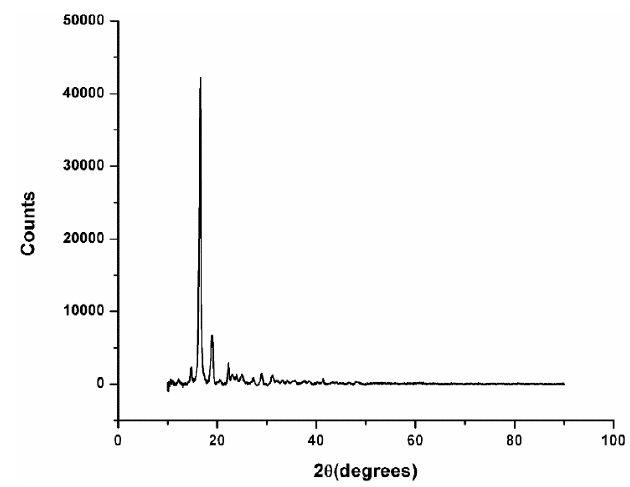
Figure 3. XRD analyses for Arboblend V2 Nature reinforced with Extrudr BDP “Pearl” material.